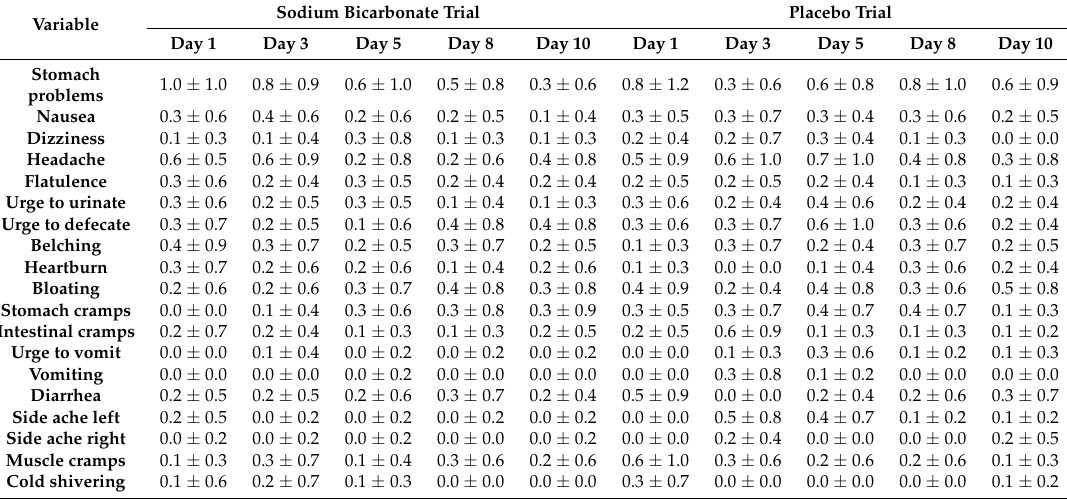
Table 2. Gastrointestinal side effects during sodium bicarbonate and placebo supplementation.